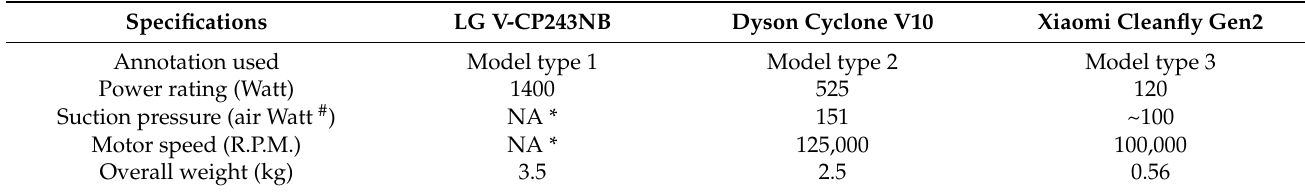
Table 1. Product specifications of the used vacuum